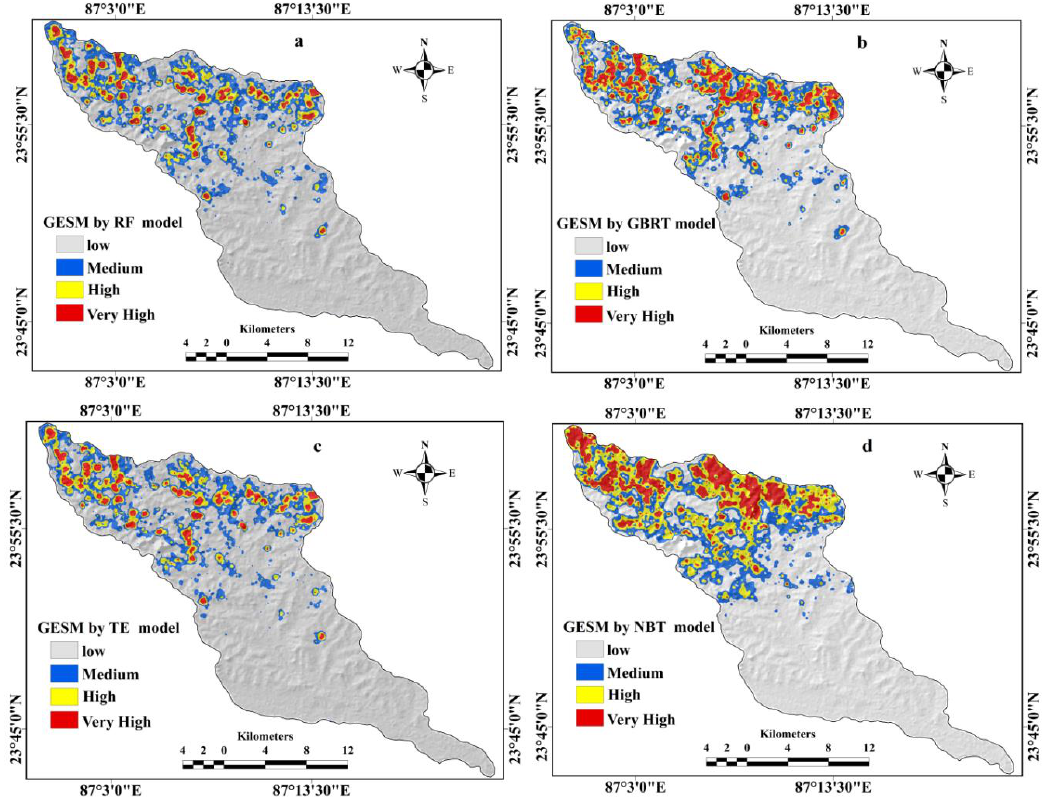
Figure 7. Gully erosion susceptibility maps (GESMs) showing ( a ) RF model, ( b ) GBRT model, ( c ) TE model, ( d ) NBT model.